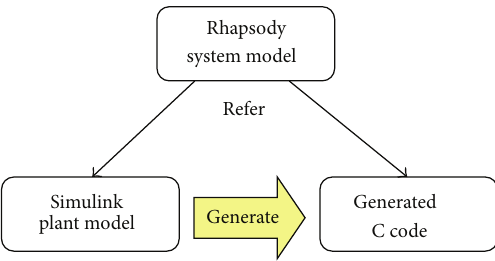
Figure 1: Importing a Simulink component.